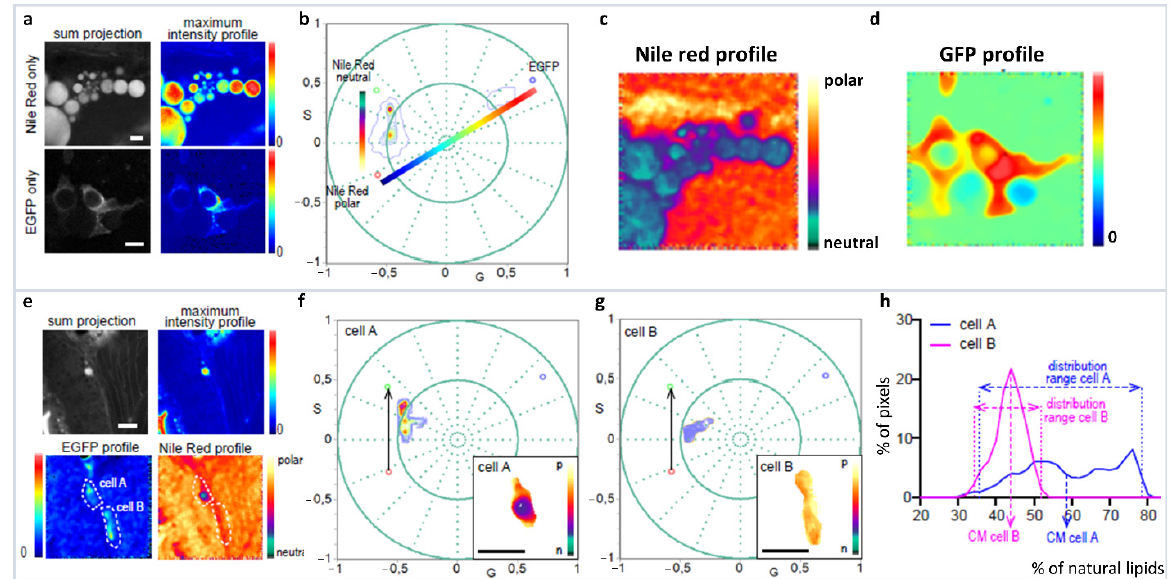
Figure 14. Analysis of the lipid metabolic profile of EGFP+ cells in the zebrafish line with the transgene fabp4 ( − 2.7): EGFPcaax. ( a – d ) Schematic representation of the three-component analysis for the Nile Red fluorescence in the presence or absence of the EGFP fluorescence. EGFP − cells let us define the neutral-polar Nile Red trajectory and EGFP+ cells without Nile Red, allowing us to identify the phasor position of the third component (GFP, identifying the specific cell-adipocyte). Notice that after three cursors were defined, a triangle has all possible linear combinations, and the third component was used to analyze the Nile Red information from the cells of interest. Two scales of colors were defined for the Nile Red profile and the EGFP profile. ( e – g ) Examples for the analysis of the Nile Red profile in two cells from the zebrafish larvae with the transgene fabp4( − 2.7): EGFPcaax at 8 dpf. Notice that the Nile Red spectrum characteristic in the EGFP+ cell is pulled towards the third component, which enables the identification and analysis of the Nile Red profile for these cells avoiding confusing the information coming from Nile Red in GFP − tissue. ( h ) “Nile Red axis” is defined as a normalized fraction of pixels along the Nile Red profile. The histogram shows the percentage of polar lipids in the region of the cell analyzed. Scale bars: A: 20 µ m; B: 50 µ m. (Panels adapted with permission from